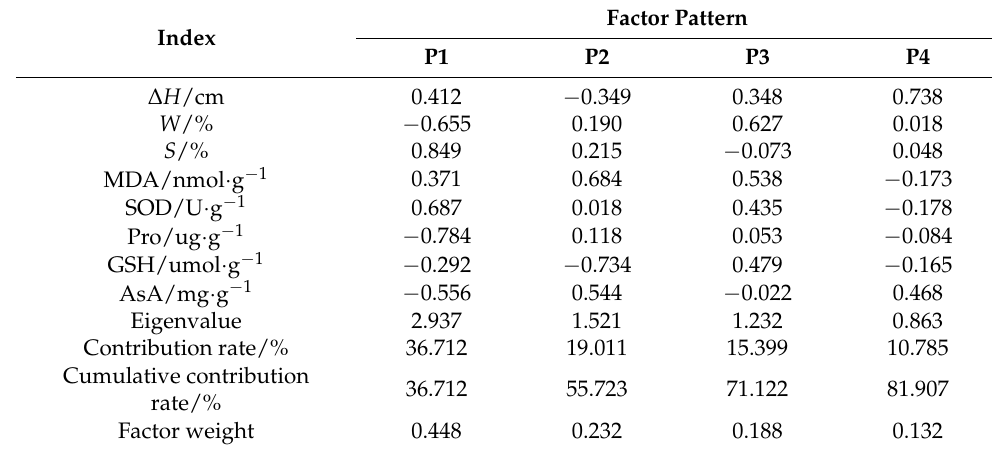
Table 5. Eigenvectors and contribution rates of principal components of all